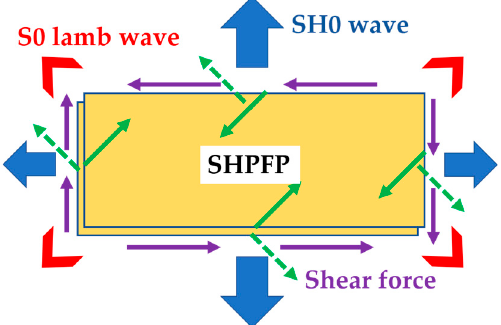
Figure 4. The configuration of the SHPFP. The yellow boxes show the active area of each PFP. The green arrows show the forces that each PFP generates. The underlying PFP generates the dotted green arrows and the overlying PFP generates the solid green arrows. At each edge, the dotted and the solid green arrow pairs are perpendicular to each other in-plane. The purple arrows designate the forces that result from the summation of the green arrows at each edge. The blue and red arrows represent excited wave modes, the target fundamental order of the shear horizontal mode (SH0) wave, and the unwanted S0 Lamb wave, respectively.